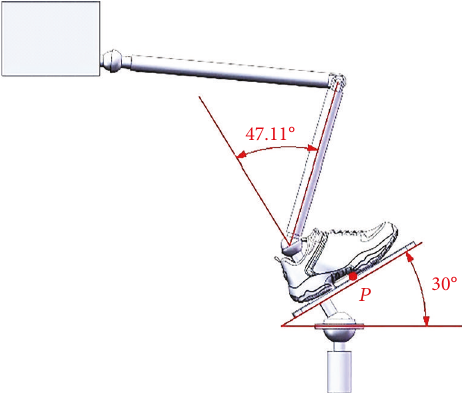
Figure 5: A posture model of ankle joint rehabilitation motion: (1) body, (2) hip joint, (3) thigh, (4) knee joint, (5) shank, (6) ankle joint, (7) foot, (8) upper platform, and (9) ball pin structure.